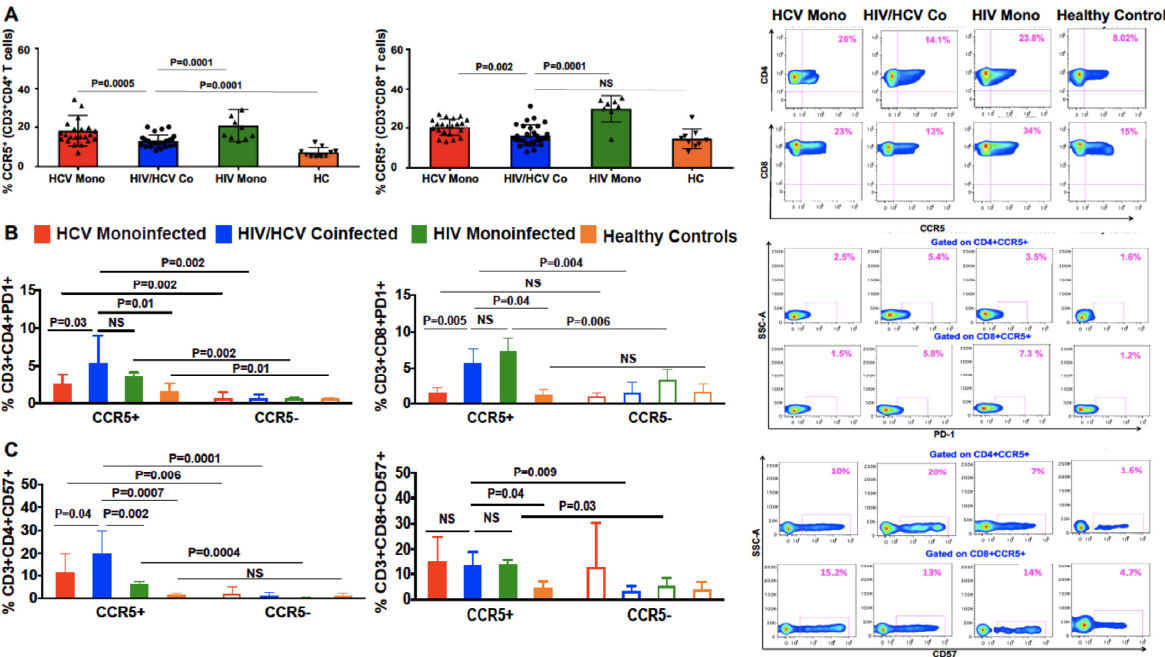
Figure 1. Peripheral blood analysis of CCR5+ and CCR5 negative CD4+ and CD8+ T cells in patients with HIV/HCV coinfection and HCV monoinfection. Flow cytometry plots from a patient and bar graphs with HCV monoinfection, HIV/HCV coinfection, HIV monoinfection and healthy controls demonstrating the differences in the percentages of ( A ) CCR5 on CD4 and CD8 T cells ( B ) Percentages of PD1 on CD4+CCR5+ and CD8+CCR5+ T cells ( C ) Percentages of CD57 on CD4+CCR5+ and CD8+CCR5+ T cells. Data are expressed as (Mean ± SEM) and differences in percentage of T cells expressing different markers between the two groups were analyzed using non-parametric Man-Whitney test in Graph Pad Prism version 6. p value less than 0.05 was considered as significant.